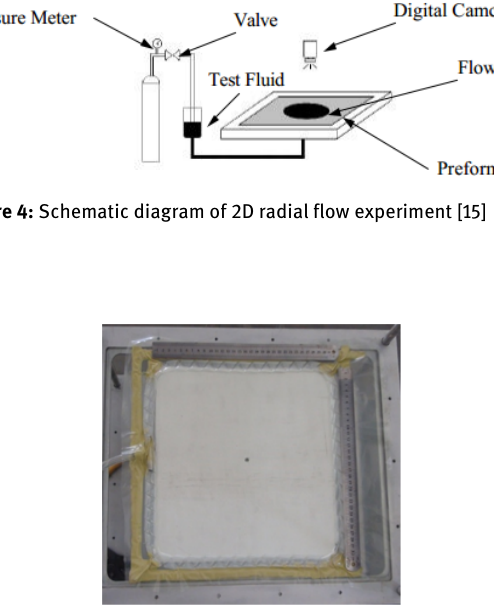
Figure 5: Experimental arrangement for 2D Radial Flow experiment